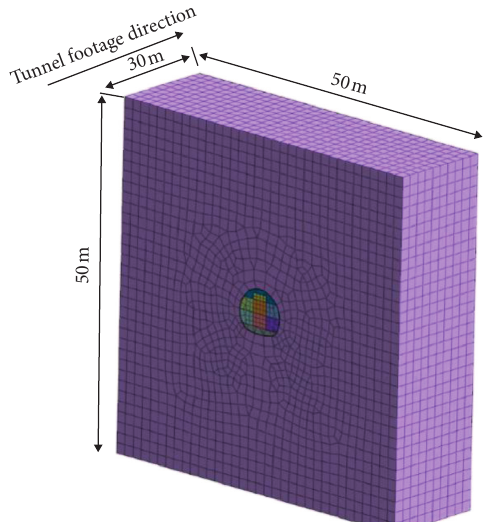
Figure 19: Schematic diagram of the tunnel model.